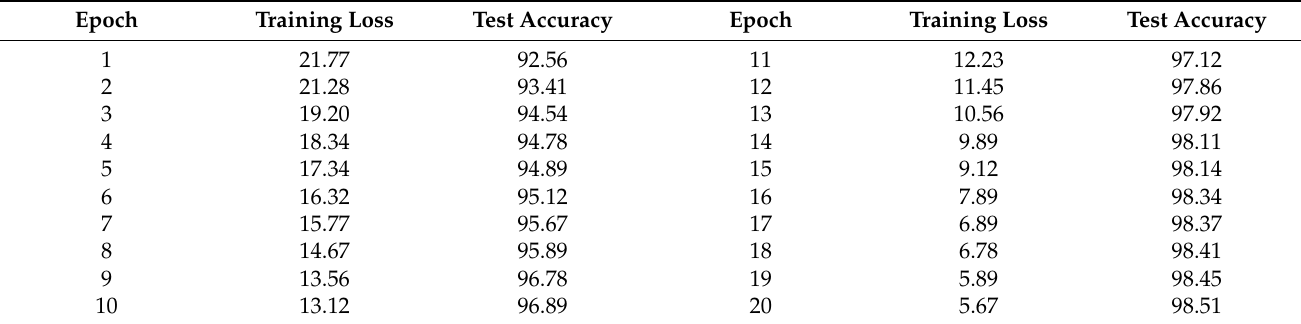
Table 1. 20-epochs data with training loss, test